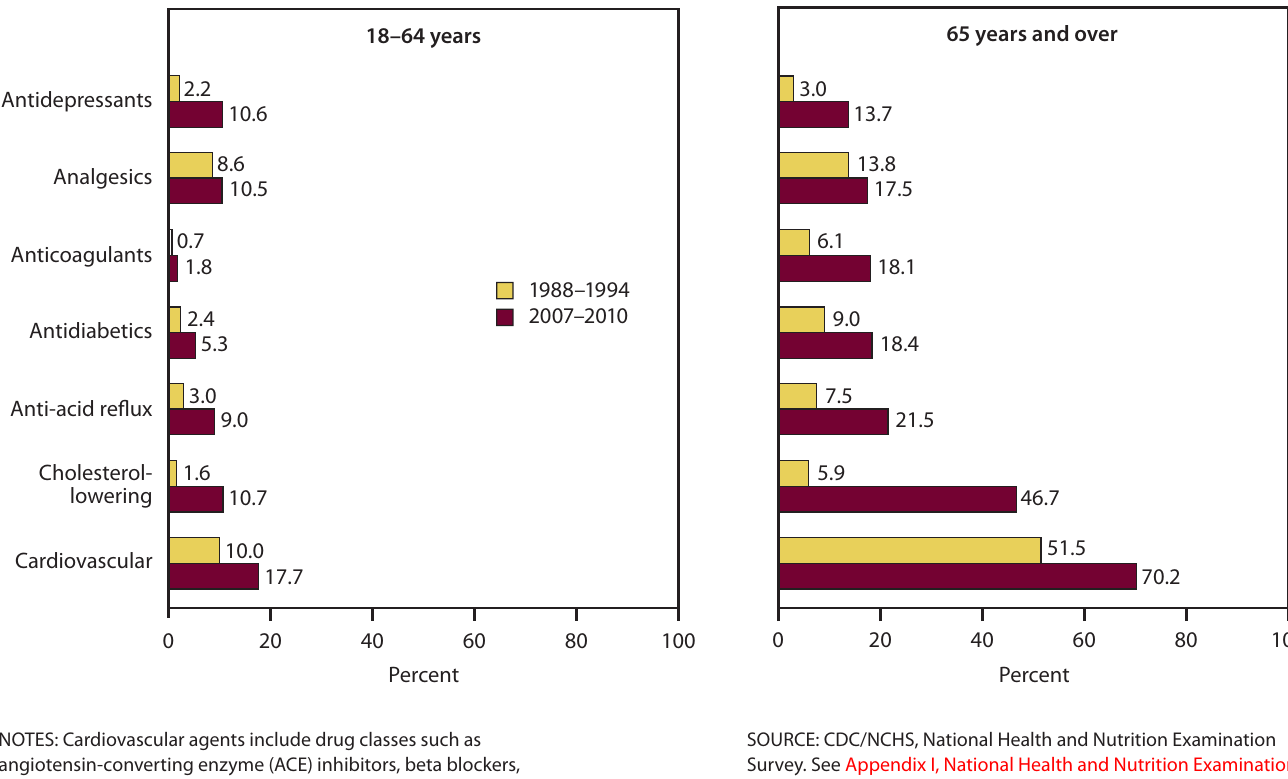
Figure 21. Prescription drug use in the past 30 days among adults aged 18 and over, by age and selected drug